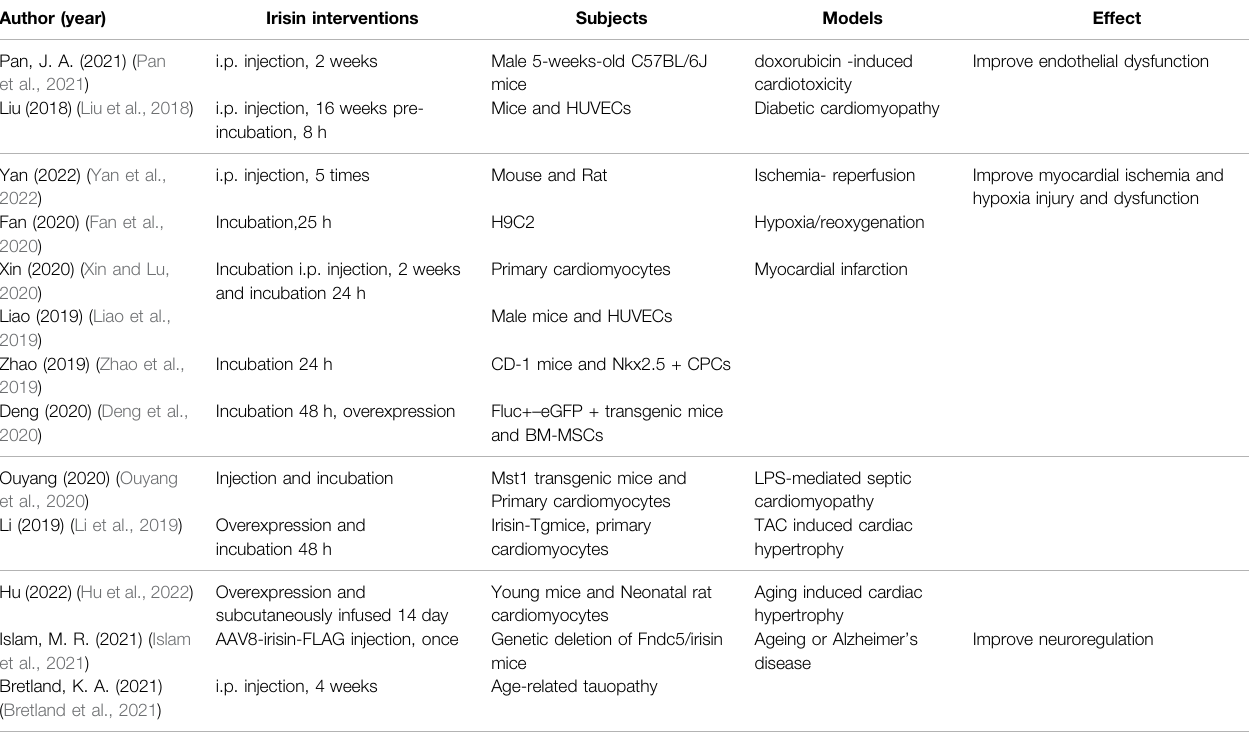
TABLE 3 | Myocardial protective effect of